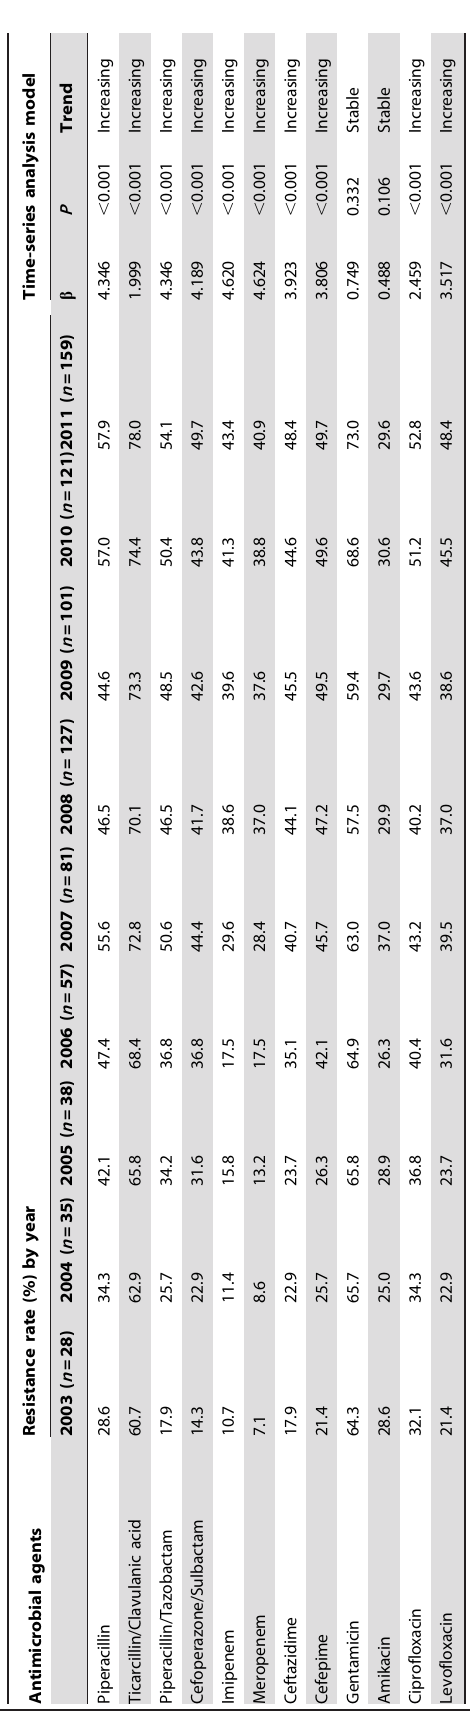
Table 1. Time series analysis demonstrated a significant increase in the resistance rates of P. aeruginosa to ticarcillin/clavulanic acid, piperacillin/tazobactam, cefoperazone/sulbactam, piperacillin, imipenem, meropenem, ceftazidime, cefepime, ciprofloxacin, and levofloxacin during nine years in the hospital ( P , 0.001). The increase of resistance rate of P. aeruginosa to meropenem was the highest during the nine-year study period. The b value indicated that resistance rate of P. aeruginosa to meropenem increased 4.6% every year according to time series analysis. During the same period, the resistance rates to gentamicin and amikacin remained stable. The rates of imipenem-resistant or meropenem-resistant P. aeruginosa (CRPA) isolated from patients with HAIs were